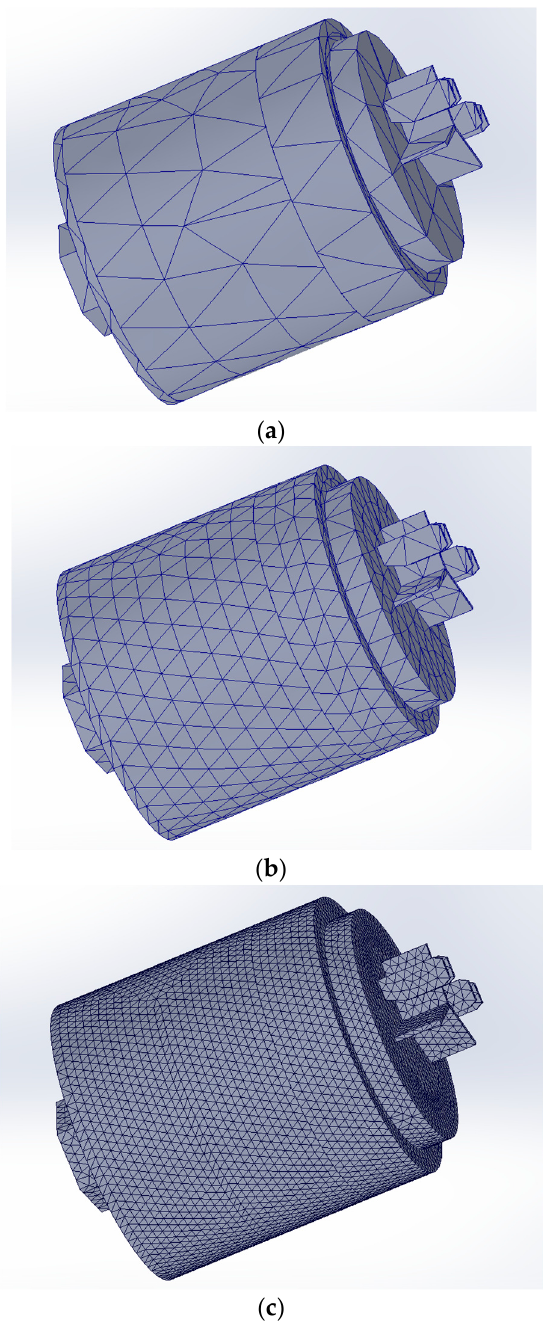
Figure 9. ( a ) Grid with a 14 mm mesh. The duration of the simulation was 9 s. ( b ) Grid with a mesh with an edge of 7 mm. The duration of the simulation was 35 s. ( c ) Grid with a mesh with an edge of 1 mm. The duration of the simulation was 690 s.